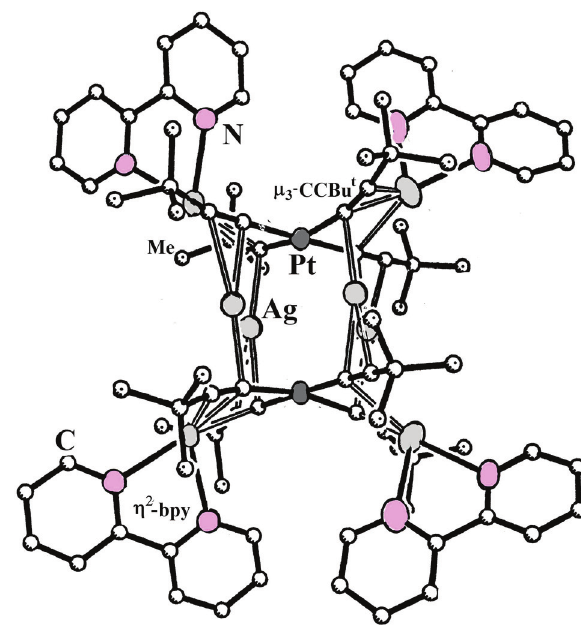
(µ-H) (CO) (η 2 -dppe)] [30]. 2 2 21